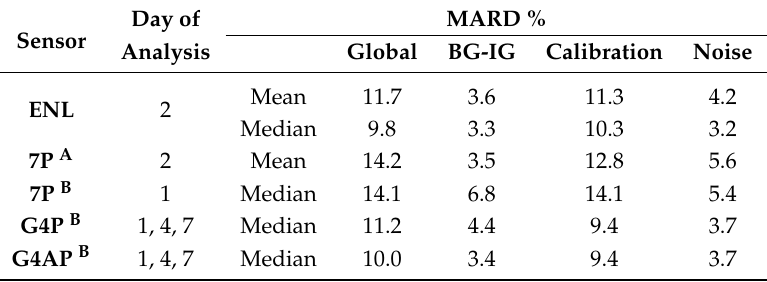
Table 4. Mean absolute relative difference (mean and median) values of the second generation Medtronic Paradigm Veo Enlite (ENL) sensor and the Dexcom SEVEN PLUS (7P), G4 PLATINUM (G4P), and advanced G4 for artificial pancreas studies (G4AP)